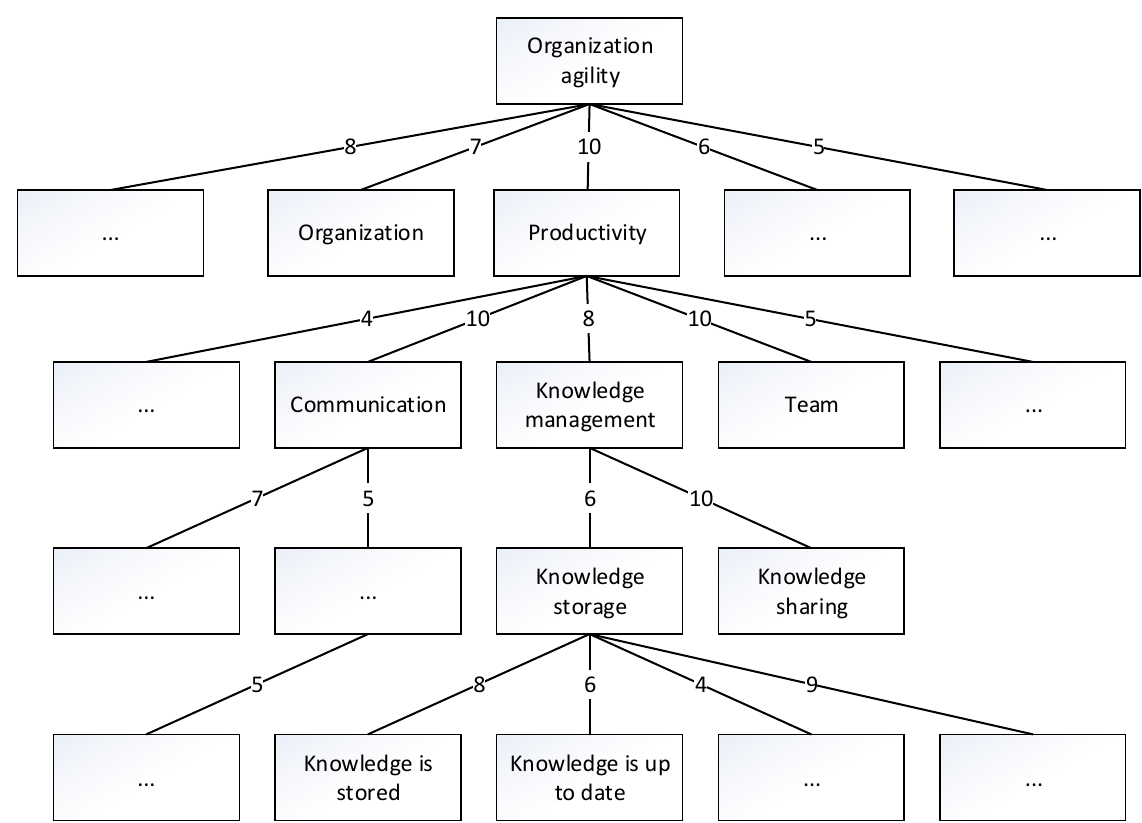
Fig. 2. Agility Influence Index sample evaluation